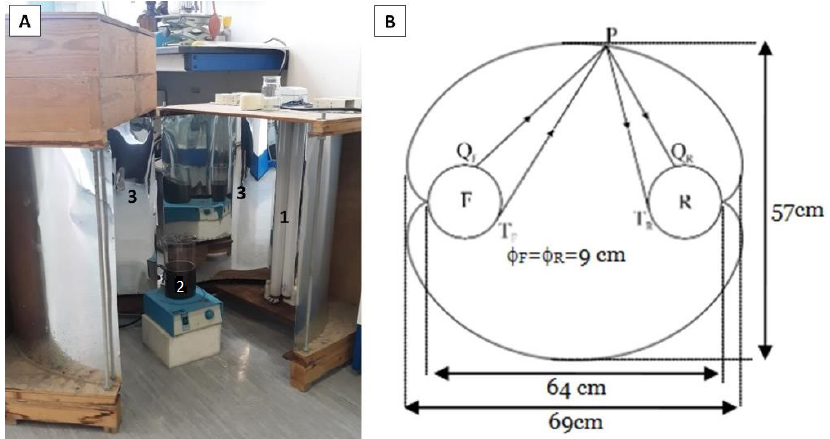
Figure 3. Experimental setup for the photo-Fenton experiments: ( A ) open montage (1 — UV lamps; 2 — reaction vessel containing the piggery effluent; 3 — mirror section); ( B ) scheme of the optical device (F — energy source; R — reaction vessel; P — generic point in the mirror section; TF, QF — light source points; TR, QR — light receiving points).